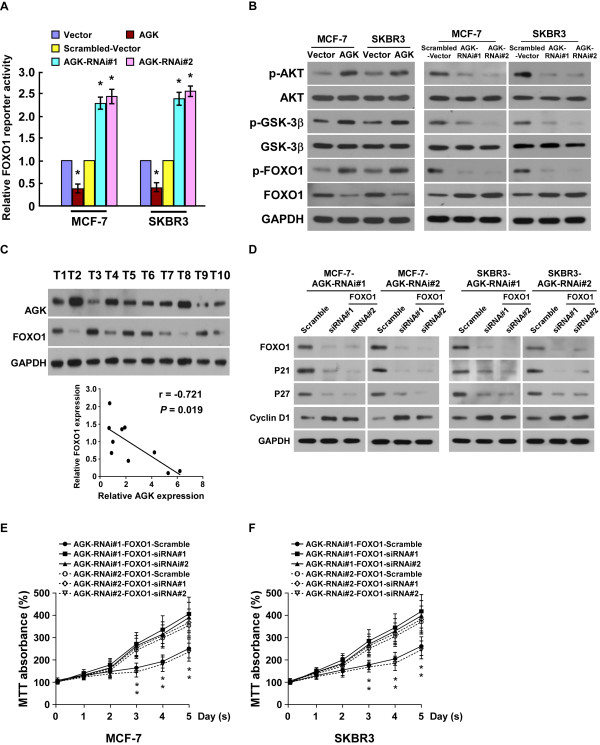
AGK downregulates FOXO1 transaactivity and activates the AKT pathway. (A) Relative FOXO1 reporter activity in AGK-infected cells, AGK-shRNA infected cells and control cells. (B) Western blotting analysis of phosphorylated-Akt (p-Akt), total Akt, phosphorylated-GSK-3β (p-GSK-3β), total GSK-3β, phosphorylated-FOXO1 (Ser256) and total FOXO1 proteins in MGF-7 and SKBR3 breast cancer cells. GAPDH was used as a loading control. (C) Expression (upper panel) and correlation analysis (lower panel) of AGK and FOXO1 expression in 10 freshly isolated human breast cancer samples. (D) Western blotting analysis of p21Cip1, p27Kip1, cyclin D1 and FOXO1 proteins in the indicated breast cancer cell lines. GAPDH was used as a loading control. (E, F) The MTT assay shows that silencing FOXO1 increased the proliferation of AGK-silenced cells as determined by an MTT assay. Error bars represent SD from three independent experiments. *P < 0.05.